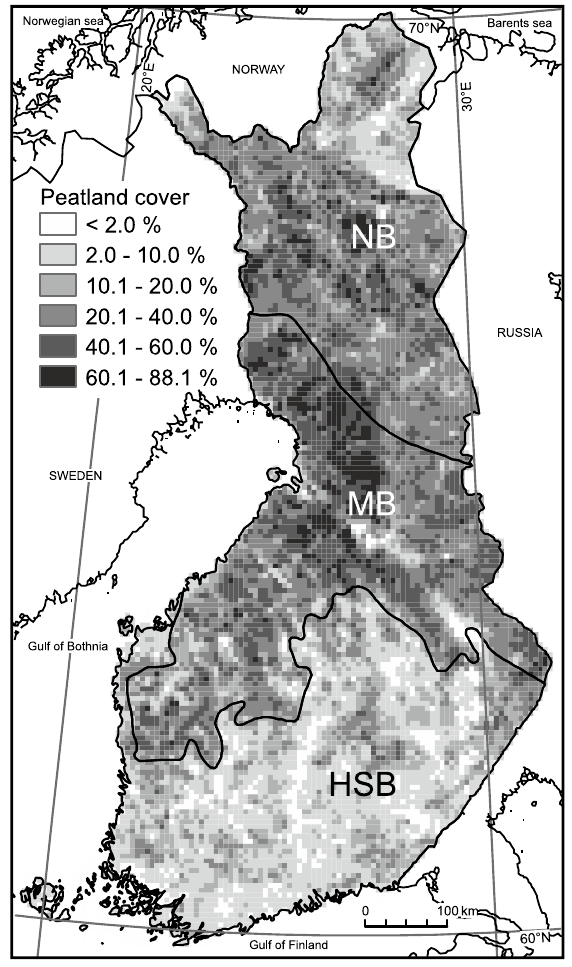
Figure 1. Peatland cover in Finland. Peatland refers here to all environments with a surface peat layer. Percentage cover is shown for 6  6 km squares (TM35 1:10,000 map sheets). HSB = hemiboreal and southern boreal zone, MB = middle boreal zone, NB = northern-boreal zone (peatland data: National Land Survey of Finland and SYKE; climatic-phytogeographical zones: SYKE; base map: